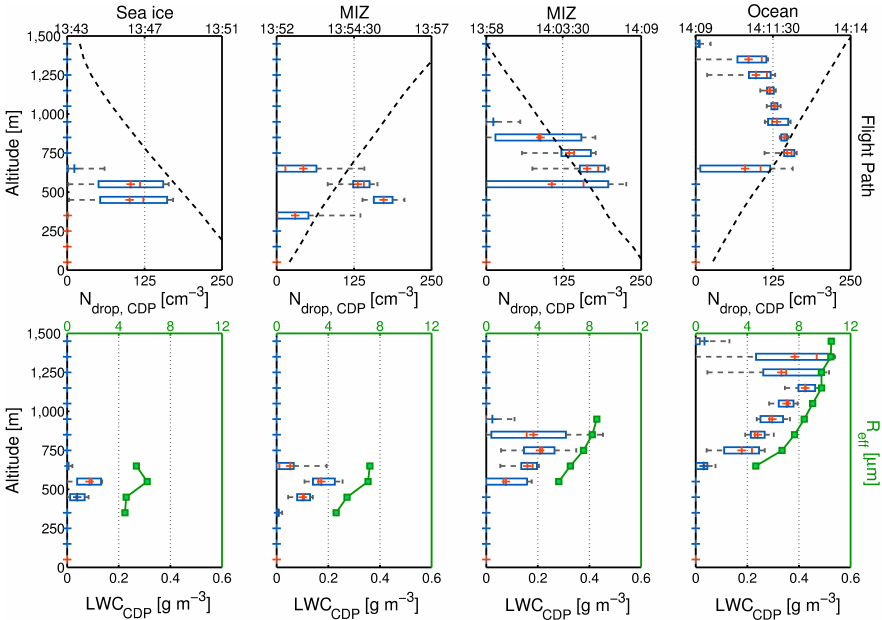
Figure 12. CDP data from the sawtooth profiles. Cloud droplet number concentration (cm − 3 , top row) and derived LWC (gm − 3 , bottom row) are shown. Box edges again indicate the 25 and 75% thresholds of the data, mean values are shown as a red cross and outliers extend to the 10 and 90% thresholds of the data. The altitude of the aircraft is indicated (black, dashed) in the top row and mean droplet effective radius – in µm, derived from CDP measurements – is shown (green) in the bottom row. Columns indicate the different profiles, transitioning from sea ice to ocean from left to right.